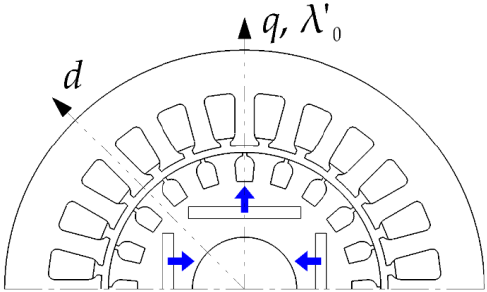
Figure 3. Directions of the d- and q-axes relative to the direction of magnetization of the permanent magnets in the rotor (shown by blue arrows).